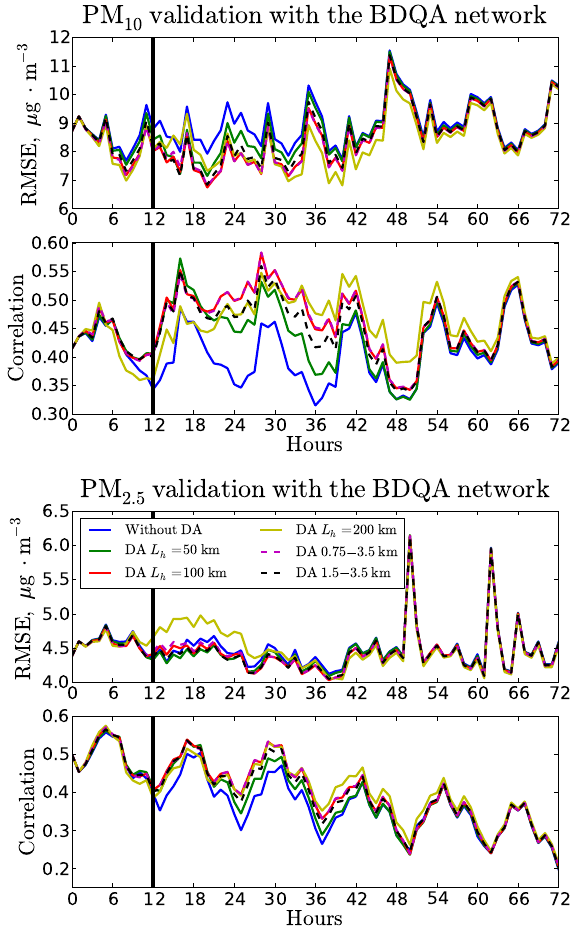
Figure 10. The top (or bottom) panel shows the time evolution of the RMSE (µgm − 3 ) and the correlation of PM 10 (or PM 2 . 5 ) aver- aged for each of the six different experiments. The scores are com- puted for the BDQA network (hourly data). The vertical black lines denote the separation between the 12h assimilation period (to the left of the black lines) and the 60h forecast period (to the right of the black lines). The “DA L h = 50km”, “DA L h = 100km” and “DA L h = 200km” simulations correspond to an assimilation al- titude range from 1.0 to 3.5km. The “DA 0.75–3.5km” and “DA 1.5–3.5km” simulations correspond to L h = 100km.